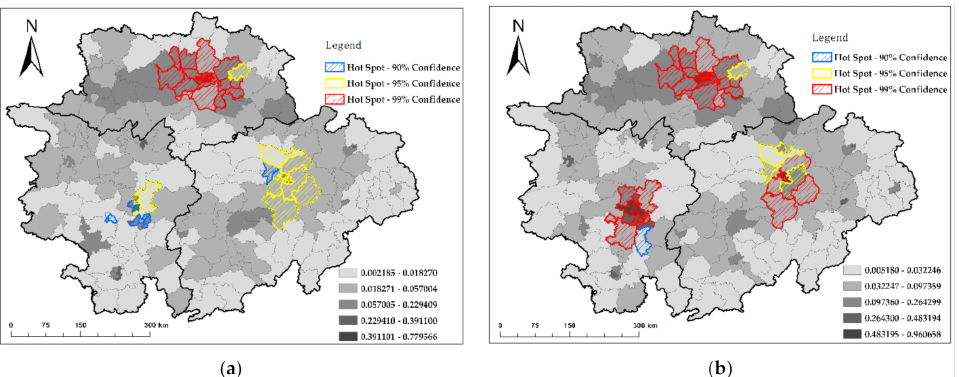
Figure 4. Spatial and hotspot patterns of LUI in the urban agglomeration of the middle reaches of the Yangtze River in 2010 and 2017. ( a ) Shows the spatial and hotspot patterns in the urban agglomeration in the middle reaches of the Yangtze River in 2010. ( b ) Refers to the spatial and hotspot patterns in the urban agglomeration in the middle reaches of the Yangtze River in 2017. Hotspots refer to the statistically significant high-value clusters of LUI, whereas coldspots indicate statistically significant low-value clusters of LUI. No coldspots existed in 2010 and 2017. The hotspots were mainly clustered in Wuhan, Changsha, and Nanchang areas. In the Wuhan urban agglomeration, the range of significant hotspots in 2017 is identical to that of 2010. The LUI of all the counties in Wuhan and Ezhou cities are